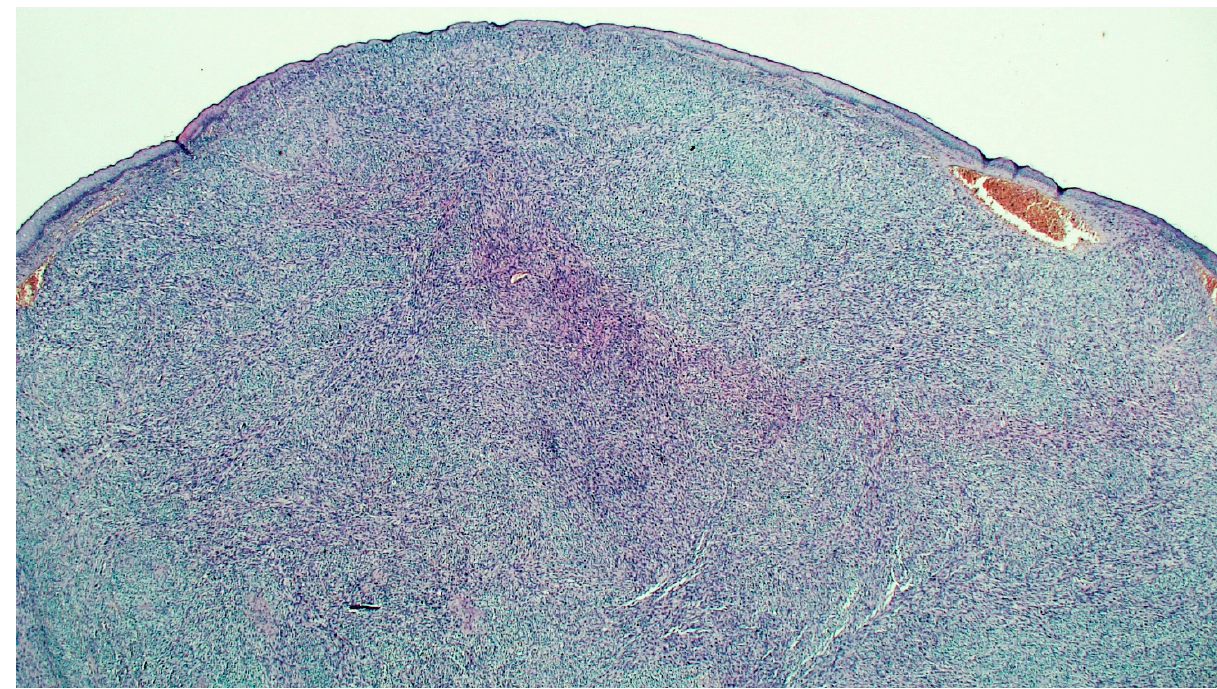
Figure 2. Histopathological features of the primary cutaneous leiomiosarcoma at low magnification.